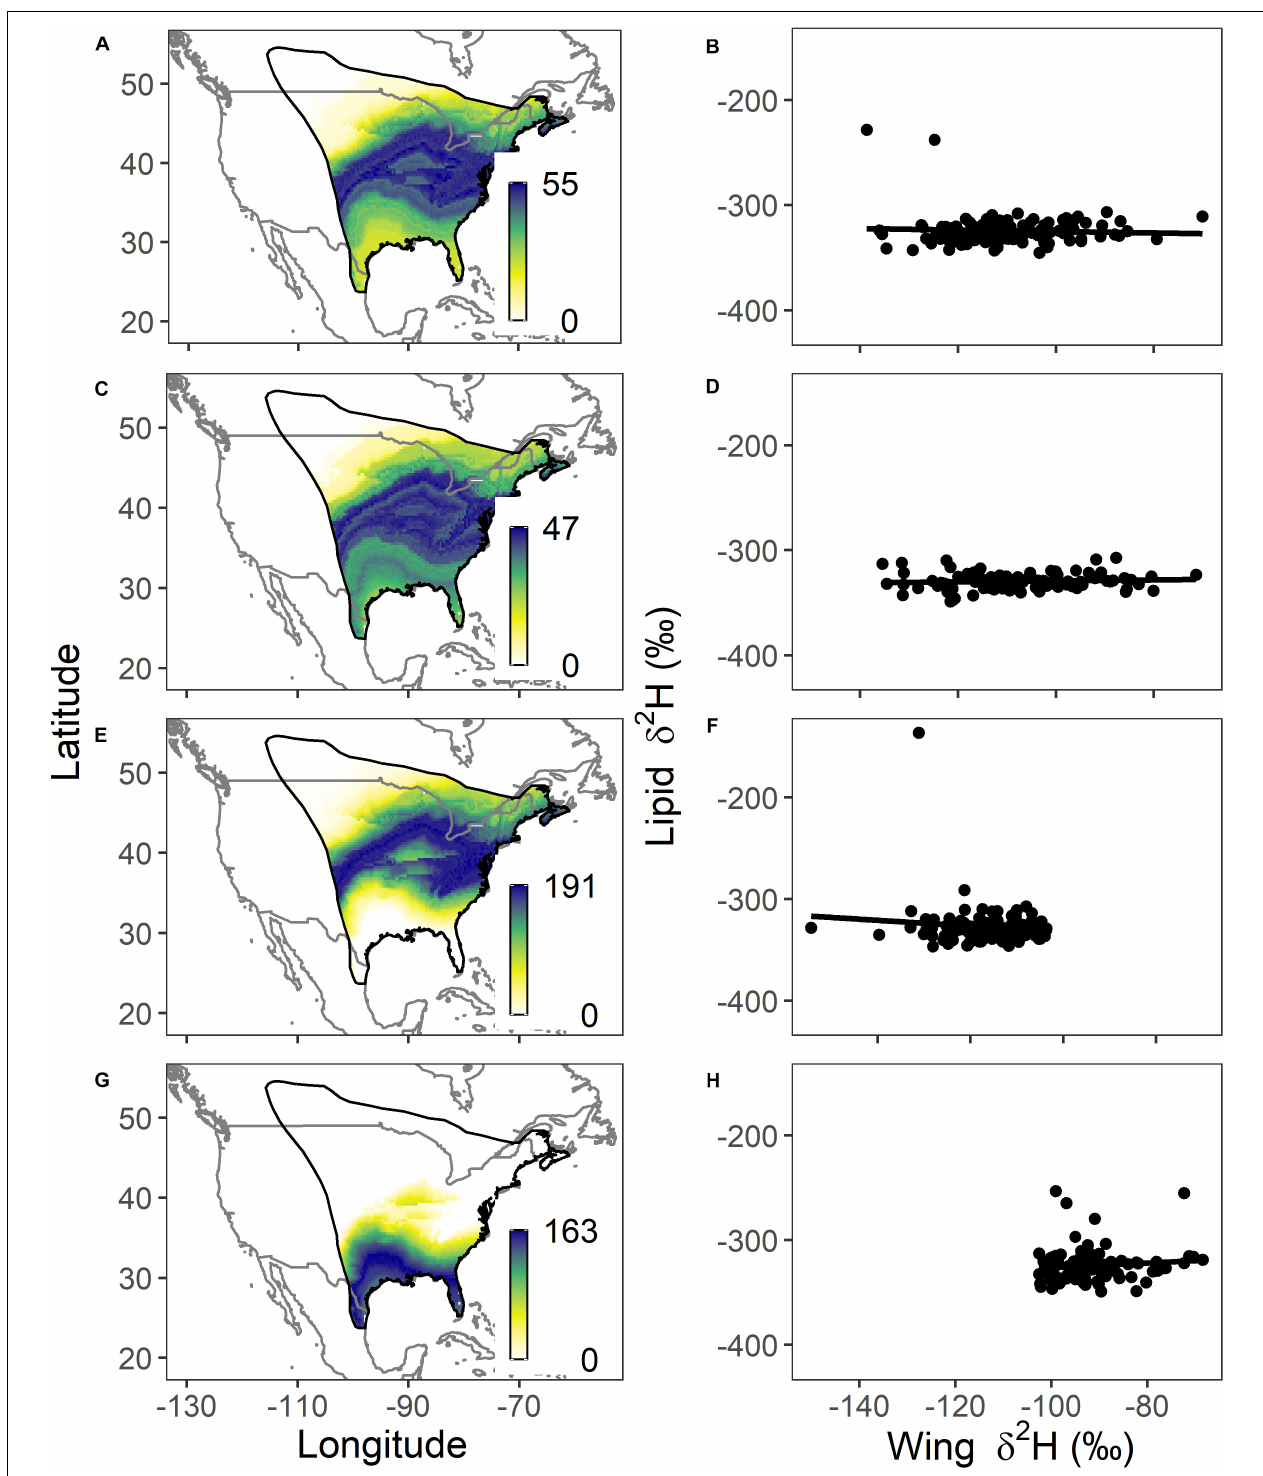
FIGURE 3 | Depictions of potential natal locations and the relationship between lipid δ 2 H and wing δ 2 H for monarchs sampled during migration for (A,B) Queretaro and Nuevo Leon (2016) ( n = 130), (C,D) Queretaro and Guanajuato (2017) ( n = 99), (E,F) Coahuila and Nuevo Leon (2017) with wing δ 2 H < − 103 ( n = 118) and ( n = 98). The legend represents the number of individuals at each pixel with wing δ 2 H values (G,H) Coahuila and Nuevo Leon (2017) with wing δ 2 H > − 103 (cid:104) consistent with those predicted for that location based on a 2:1 odds ratio. In all cases, results reveal that monarchs represented diverse breeding origins but there (cid:104) was, in general, no relationship between natal origin and accumulated lipid stores.